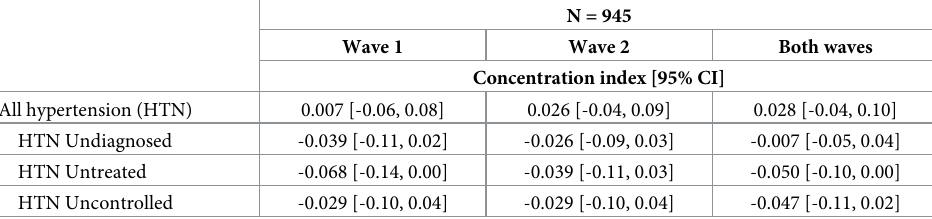
Table 5. Concentration indices of all hypertension and undiagnosed, untreated, and uncontrolled